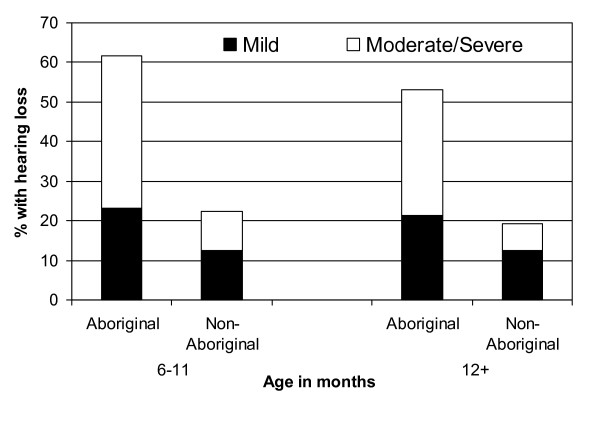
Prevalence of moderate-severe and mild hearing loss in Aboriginal and non-Aboriginal children aged 6–11 and 12–24 months of age.